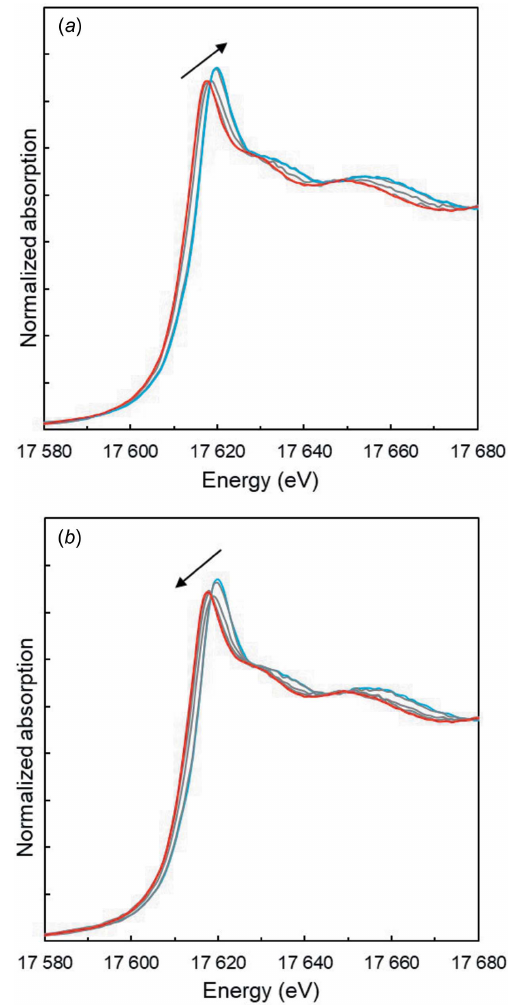
Figure 2 Normalized Np L 3 -edge XANES spectrum for ( a ) oxidation and ( b ) reduction experiments. The red spectrum is the pure Np V XANES spectrum and the blue spectrum is the pure Np VI XANES spectrum. The grey spectrum resamples intermediate